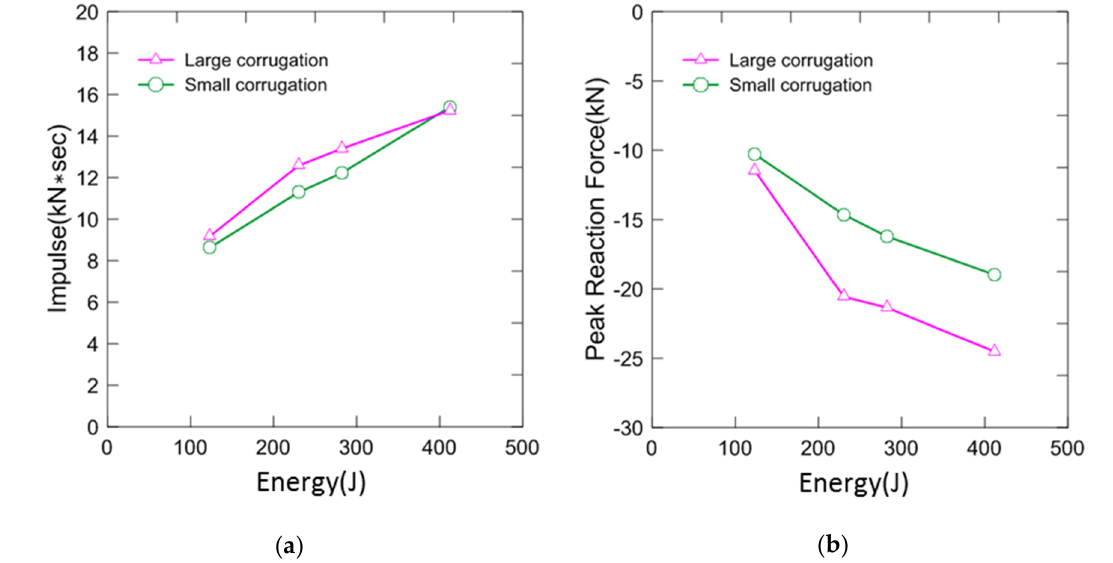
Figure 5. ( a ) Impulse from reaction force and ( b ) maximum reaction force in accordance with impact energy.